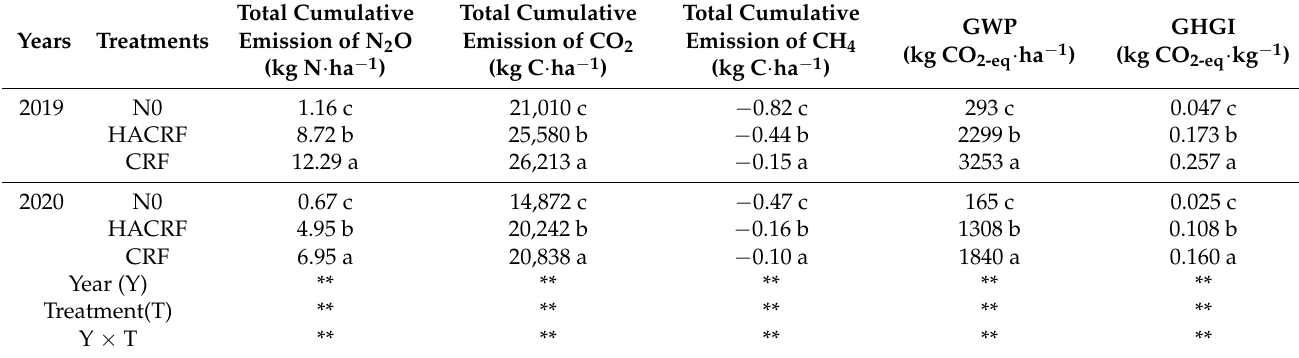
Table 3. Effects of humic acid added to controlled-release fertilizer on the accumulated greenhouse gas emissions, GWP and